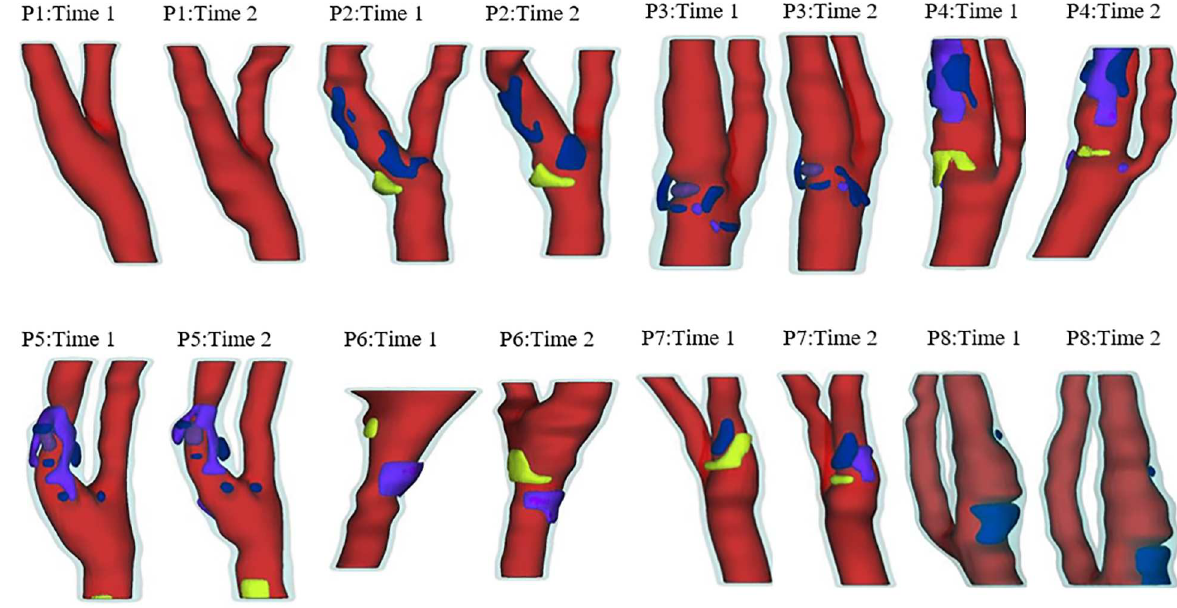
Fig 1. 3D plots of re-constructions 3D geometries of the 16 plaques (8 time pairs). Red: Lumen; Light blue: Vessel; Yellow:Lipid- rich core; Blue: Calcification; Dark Blue: Loose Matrix.